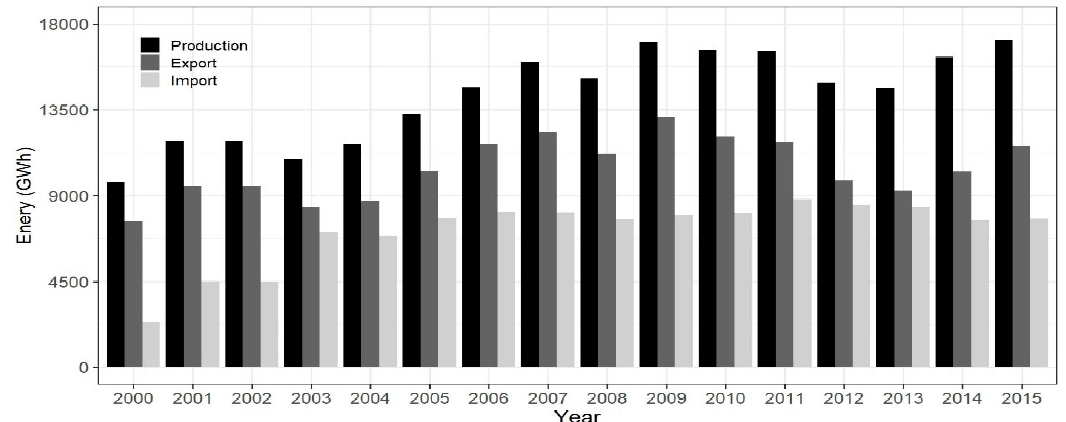
Figure 1. Electricity production and use in Mozambique. Source: own illustration with information from [5,7,8].